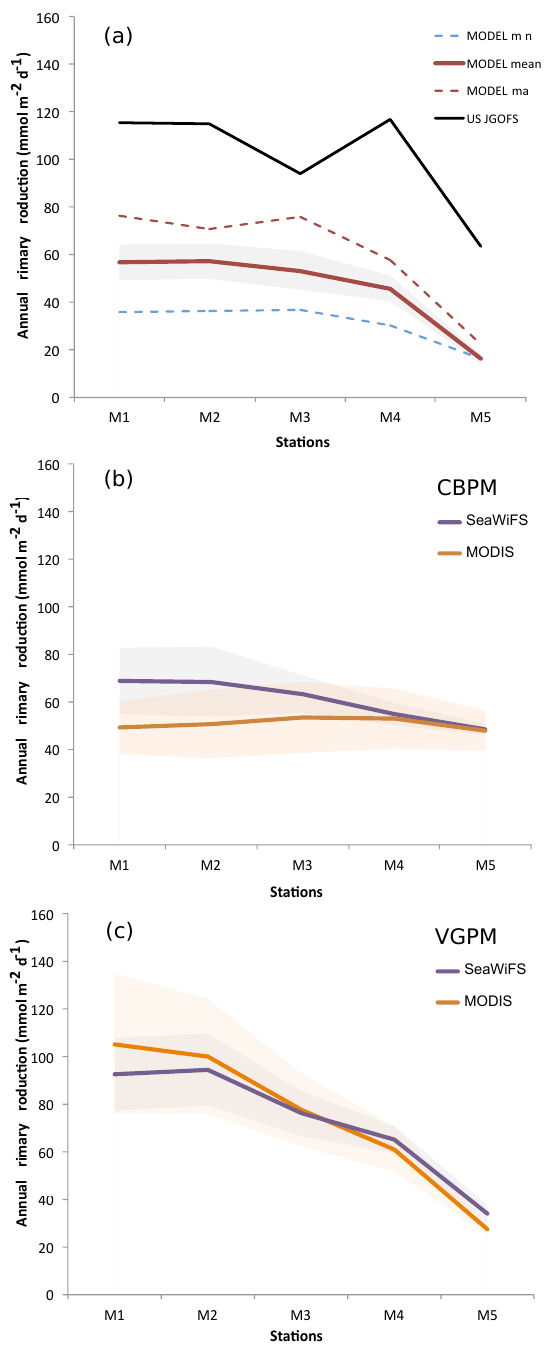
Figure A5. Biological productivity at mooring stations M1 to M5 on a transect extending 1500km from the coast of Oman. (a) Annual-mean primary production fluxes at stations M1 to M5 (Lee et al., 1998) as estimated from in situ observations (black) and simulated in the model (red). The dashed lines refer to mod- eled maximum (red) and minimum (blue) annual production. The shading indicates the ± 1 standard deviation from the model mean. (b–c) Satellite-based estimates of annual-mean primary production fluxes at the M1 to M5 stations using the CbPM (b) and VGPM (c) algorithms and the SeaWiFS and MODIS sensors. The shading in- dicates the ± 1 standard deviation from the mean.